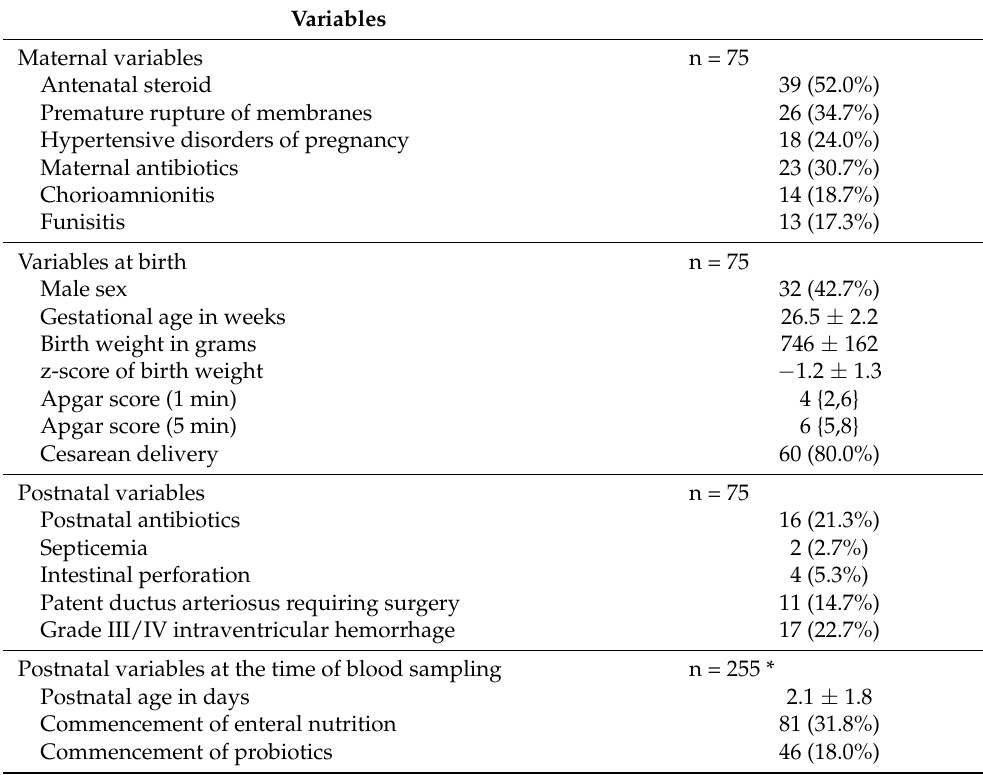
Table 1. Clinical backgrounds.